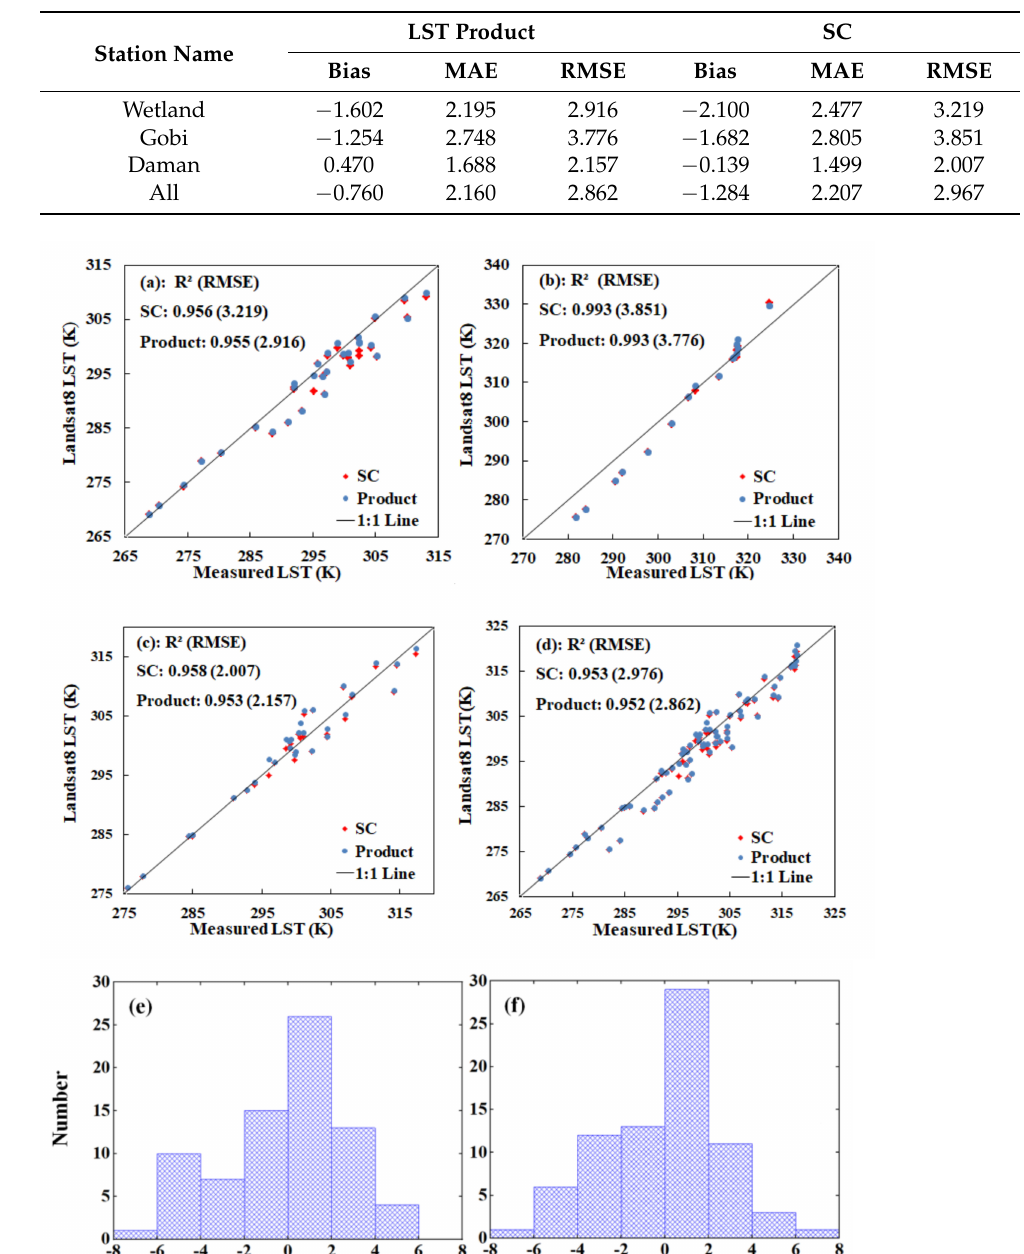
Table 2. The bias (K), MAE (K), and RMSE (K) of retrieved LST over stations.